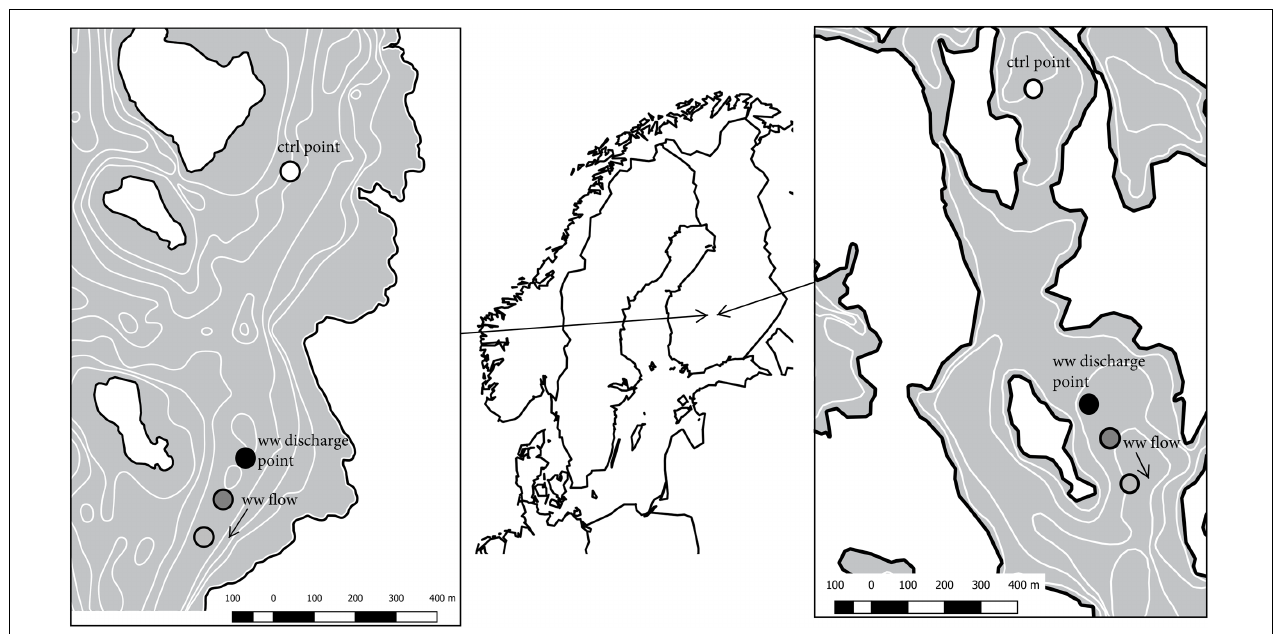
FIGURE 1 | Study sites and sampling points. White points represent control sampling points, black points wastewater discharge sampling points, dark gray 100 m downstream sampling points and light gray 200/250 m downstream sampling points. Left: Keuruu, right: Petäjävesi.